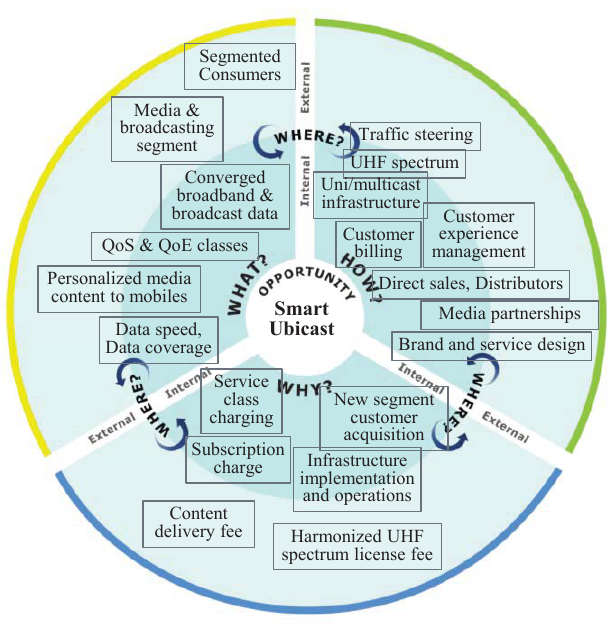
Figure 5. MNO’s the Smart ubicast business model scenario for the hybrid UHF usage